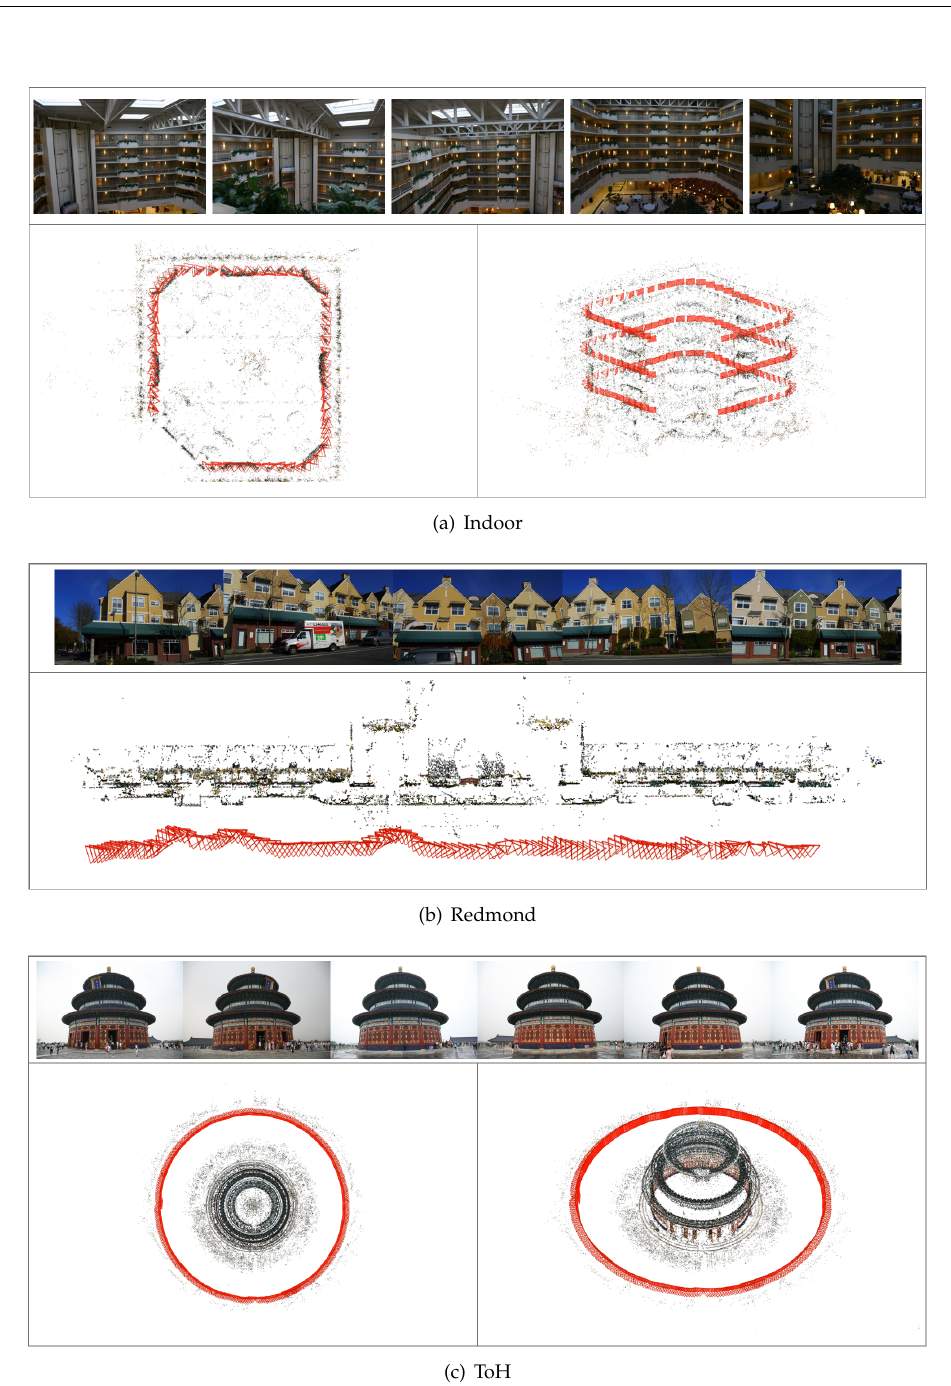
Figure 12. Sample images and reconstruction results [28] of three middle-scale datasets with repetitive structures.